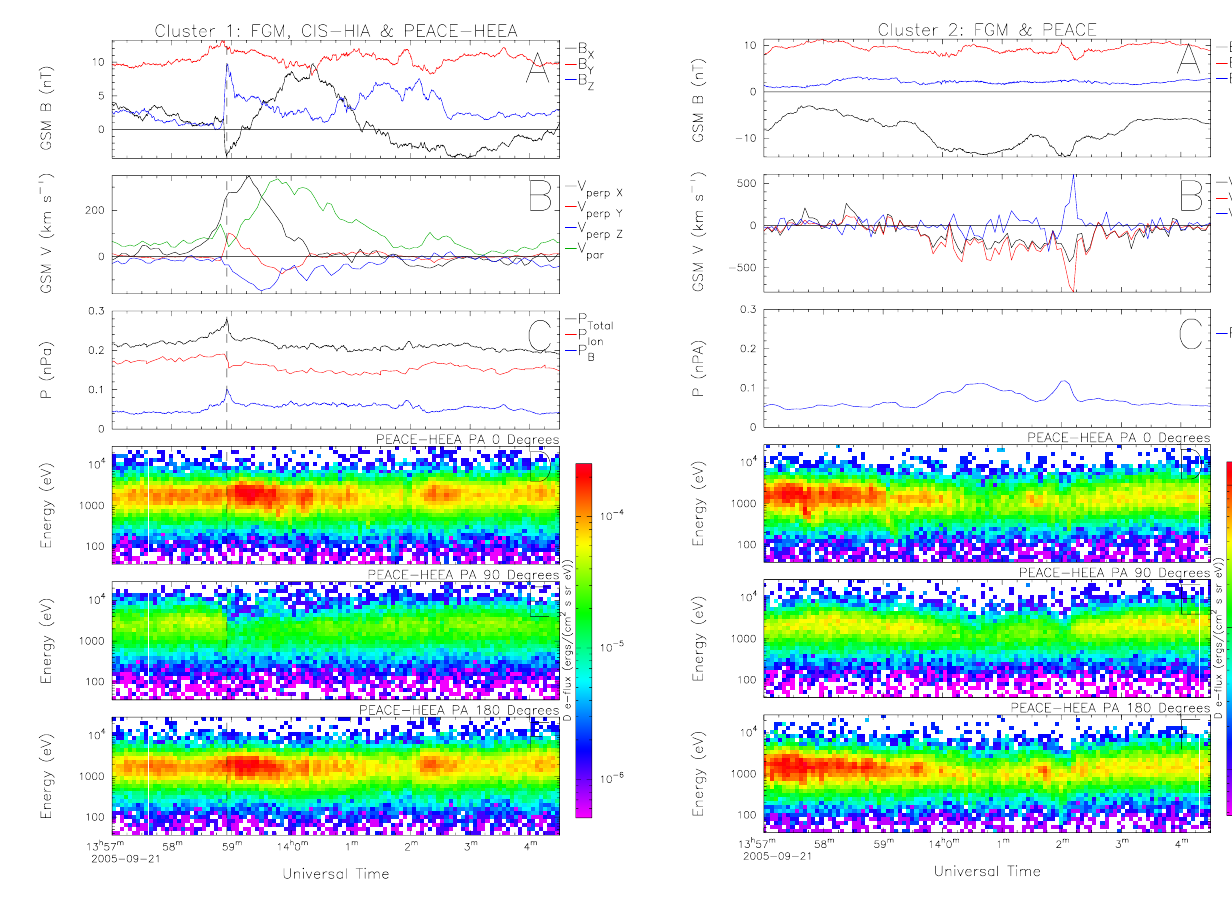
Fig. 5. C1 observations of the field dipolarisation and associated plasma features. Panel (A) shows GSM B X (black), B Y (red) and B Z (blue) from FGM; panel (B) GSM V ⊥ X (black), V ⊥ Y (red), V ⊥ Z (blue) and V // (green) for ions from CIS-HIA; panel (C) total (i.e. magnetic + ion) pressure (black), ion pressure (red) and mag- netic pressure (blue) and panels (D–F) energy time spectrograms from PEACE-HEEA for pitch angles of 0 ◦ , 90 ◦ and 180 ◦ , respec- tively. The vertical dashed line marks the entry of the spacecraft into the region of interest.